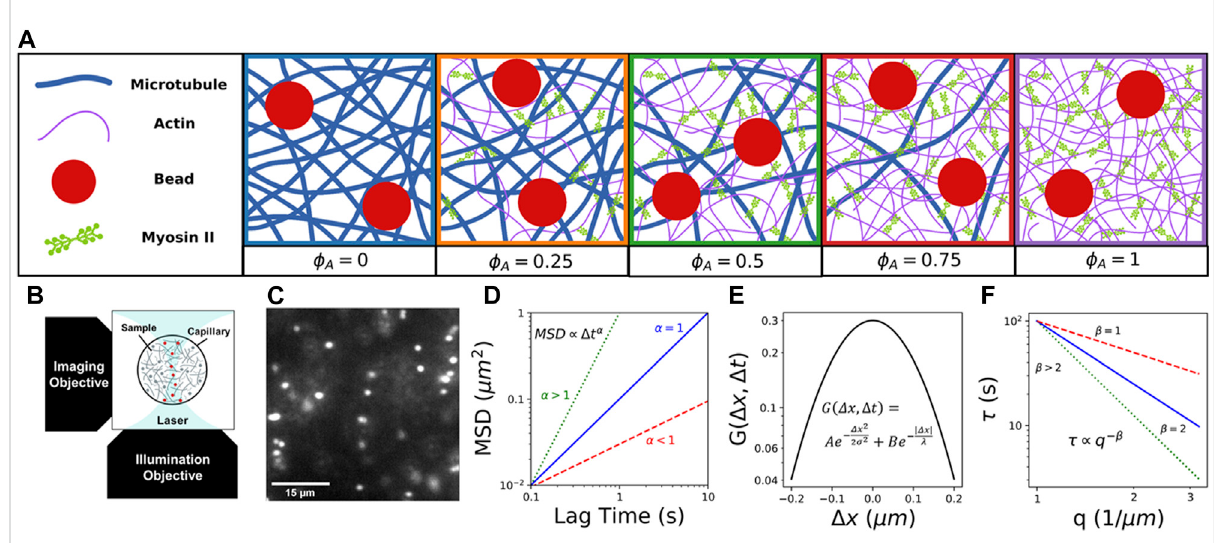
FIGURE 1 Combining light sheet microscopy with real-space single-particle tracking (SPT) and reciprocal-space differential dynamic microscopy (DDM) to characterize particle transport in active cytoskeletal composites. (A) We create composites of co-entangled microtubules (blue) and actin fi laments (purple) driven out-of-equilibrium by myosin II mini fi laments (green). We track the motion of embedded 1 μ m beads (red) in composites with varying molar fractions of actomyosin, which we denote by the fraction of actin comprising the combined molar concentration of actin and tubulin (5.8 μ M ) : ϕ A (cid:2) 0.0 . 25 , 0 . 5 , 0 . 75 , 1. In all cases, the molar ratio of myosin to actin is fi xed at 0.08. (B) Schematic of the light-sheet microscope we use for data collection, which provides the necessary optical sectioning to capture dynamics in dense three-dimensional samples. (C) Example framefromtime-seriesof1 μ mbeadsembeddedinacytoskeletoncomposite,usedtocharacterizeparticletransportinactivecrowded systems. (D) Cartoon of expected mean-squared displacements ( MSD ) of embedded particles versus lag time Δ t , which we compute via single- particle tracking (SPT) and fi t to a power law MSD (cid:1) Δ t α to determine the extent to which particles exhibit normal Brownian diffusion ( α (cid:2) 1, blue), subdiffusion( α < 1,red),orsuperdiffusion( α > 1,green). (E) CartoonvanHovedistribution G of x -and y -direction particledisplacements Δ d (cid:2) Δ x ∪ Δ y for a given lag time Δ t computed from SPT trajectories. The distribution shown is described by a sum of a Gaussian and exponential function expected characteristic decorrelation times τ ( q ) as a function of wave number q , which we compute by fi tting the image structure function computedfromDDManalysis.Wedeterminethescalingexponent β fromthepower-law τ ( q ) ~ q − β todetermineiftransportisdiffusive( β (cid:2) 2,blue), subdiffusive ( β > 2, green), or ballistic ( β (cid:2) 1,